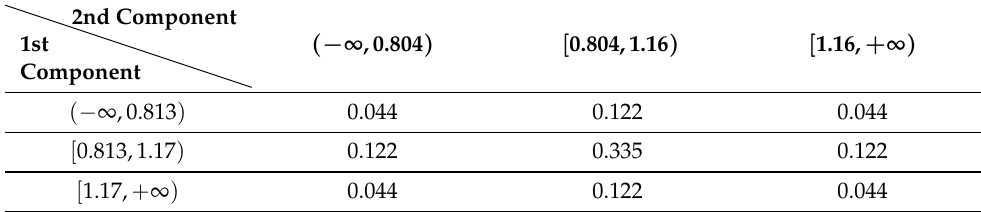
Table 4. Transition probability table for x 10 ( − ) to move with the addition of process noise v 10 .